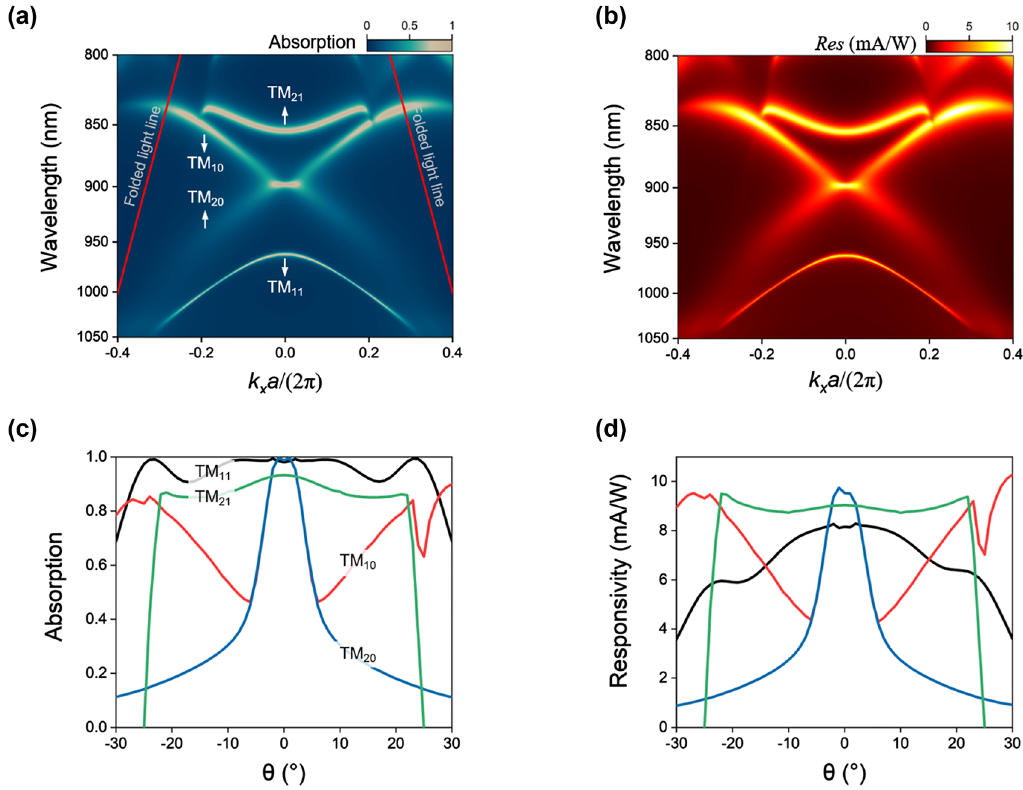
Figure 6: Effect of incident angle on the performance of three-band HEPD. Angle-resolved (a) absorption and (b) responsivity spectra of plasmonic structure. Dependence of (c) absorption and (d) responsivity of TM 10 ∼ TM 21 modesontheangleofincidence.Here, w 1 andgapare120nmand w 2 =200nmandthemirrorsymmetryofthestructureisbroken with respect to the yz